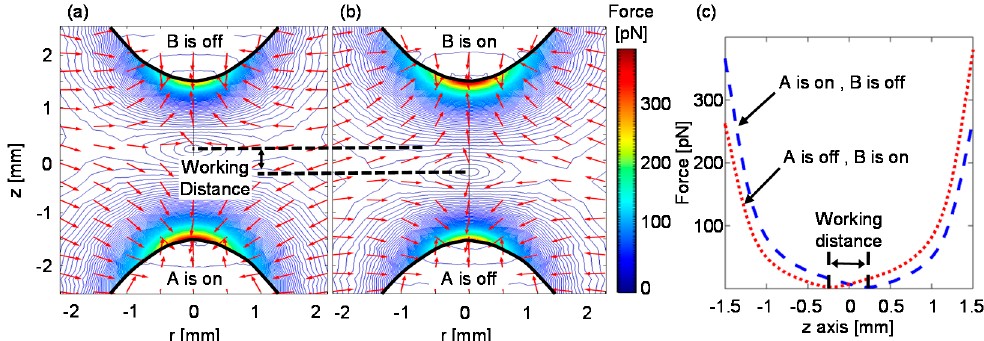
Figure 4. The magnetic force profile of two electromagnets positioned opposite each other. Simulated magnetic field profile when ( a ) electromagnet A (bottom) is active and electromagnet B (top) is inactive, and conversely, ( b ) when electromagnet A (bottom) is inactive and electromagnet B (top) is active. The distance between the parabolic pole tips ( β = 0.65 mm − 1 ) is 3 mm. The contour lines represent the magnitude of the force, and the arrows represent its direction. ( c ) The working distance is defined as the distance between the positions along the z-axis, in which the magnetic force is zero.